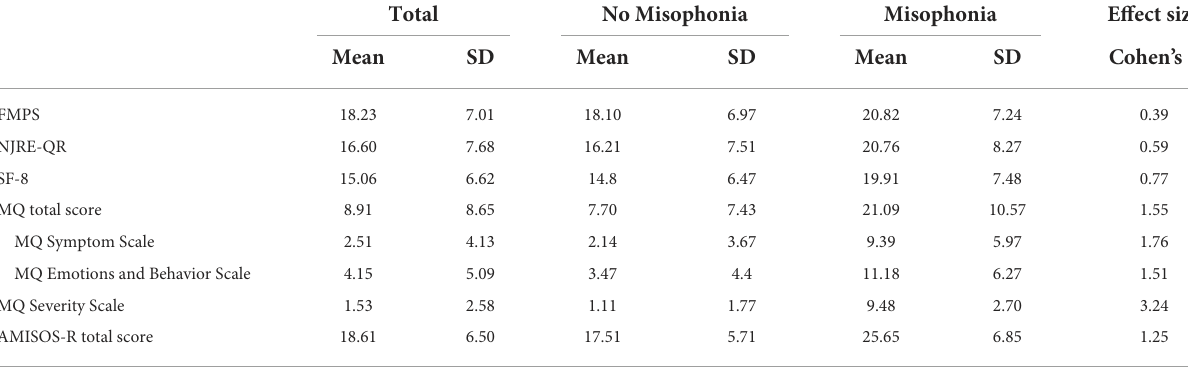
TABLE 4 Group comparison of clinical variables.